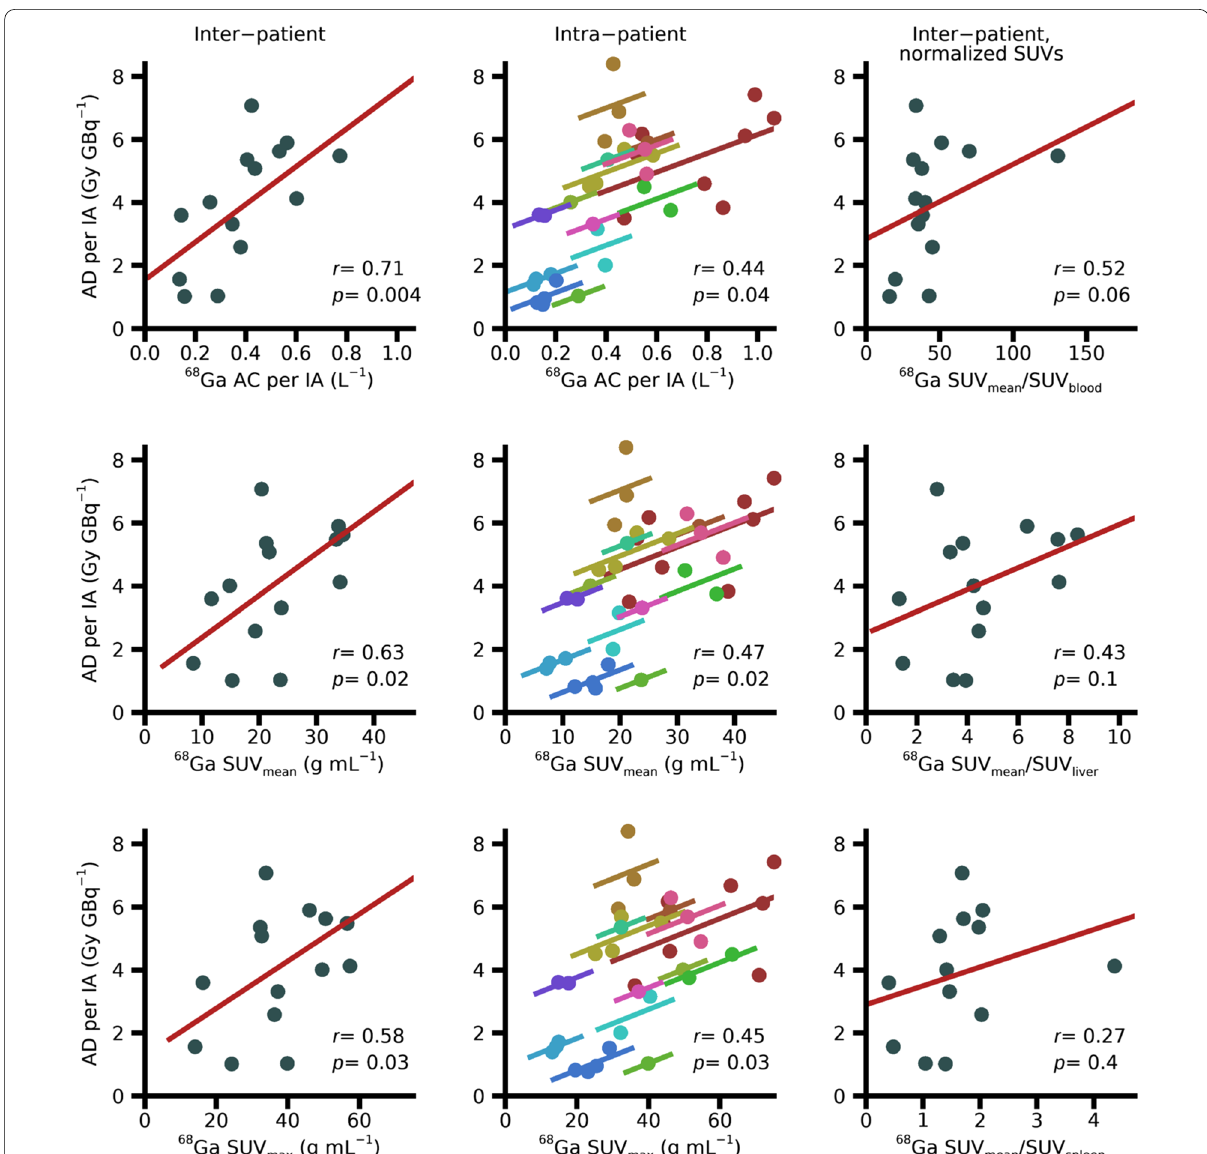
Fig. 3 Observed relationship between [ 68 Ga]Ga-DOTA-TATE and [ 177 Lu]Lu-DOTA-TATE absorbed doses to tumours. Inter-patient (left and right columns) and intra-patient (middle column) analyses of the 177 Lu-absorbed dose per injected activity are shown as a function of the 68 Ga activity concentration per injected activity, 68 Ga-SUV mean , 68 Ga-SUV max , and various 68 Ga-SUV ratios. Data underlying the inter-patient analyses are the means across the tumours in each patient, whereas the intra-patient analyses are based on data for the separate tumours in each patient, as indicated by the different